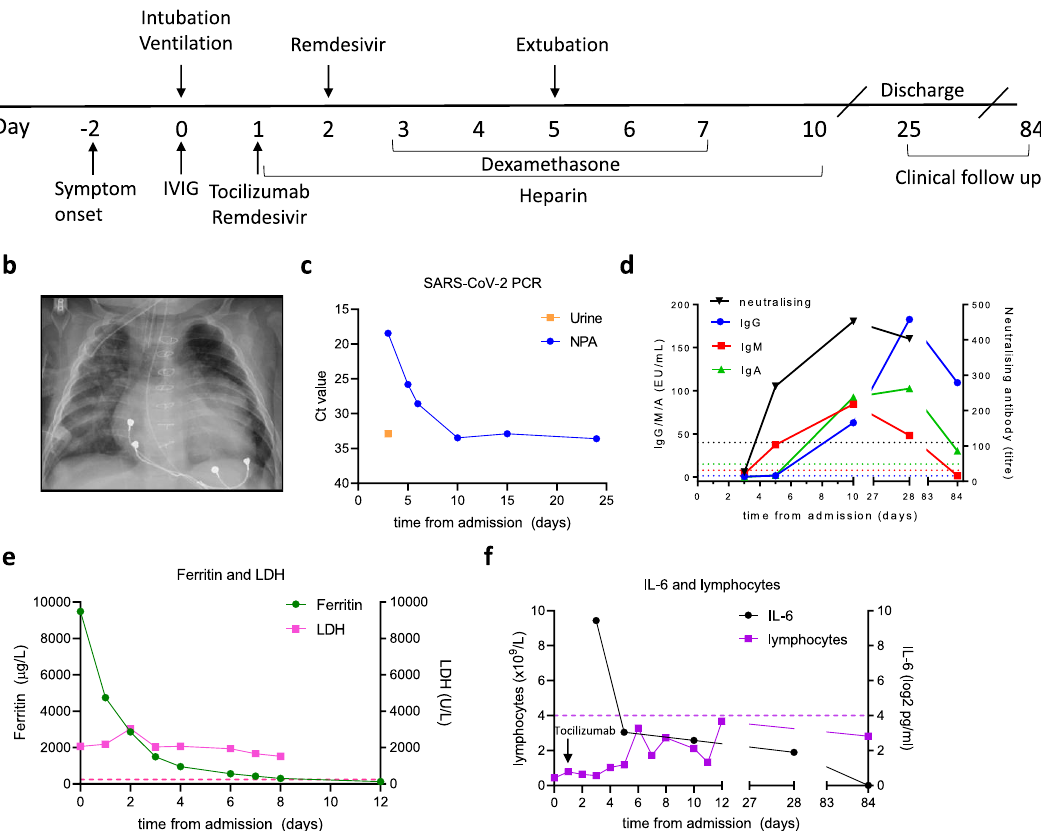
Fig. 1 Clinical and laboratory characteristics of an infant with severe COVID-19. A Clinical timeline showing immuno-modulatory therapies in relation to clinical course. B Plain chest fi lm performed on admission illustrating bilateral interstitial in fi ltrates with left lower lobe collapse and consolidation. C Virologic fi ndings illustrating SARS-CoV-2 Cycle threshold Ct values in naso-/oropharyngeal and urine specimens that reduce in association with clinical improvement. D Serum IgG, IgM, and IgA to S1 using in-house ELISA modi fi ed from Mount Sinai Laboratories, USA; and microneutralisation